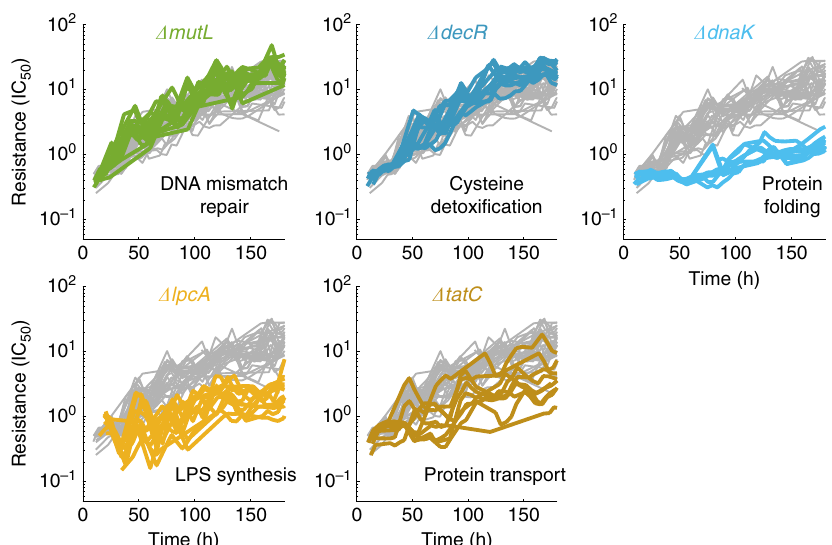
Fig. 4 Diverse cellular functions, including chaperones, LPS biosynthesis, and DNA repair, affect resistance evolution. Resistance (IC 50 ) over time as in Fig. 3a for several strains with deletions of genes that have an effect on resistance evolvability, but are not immediately related to ef fl ux pumps. Δ mutL and Δ decR show slightly increased evolvability, Δ mutL presumably due to the increased mutation rate. Δ dnaK , Δ lpcA , and Δ tatC , which are mutants in protein folding, LPS biosynthesis and protein export, respectively, show decreased evolvability. Gray lines show resistance over time for 22 replicates of the reference strain ( Δ lacA ) for comparison. Data are from experiments M2 and M3 (Methods, Supplementary Table 2, Source